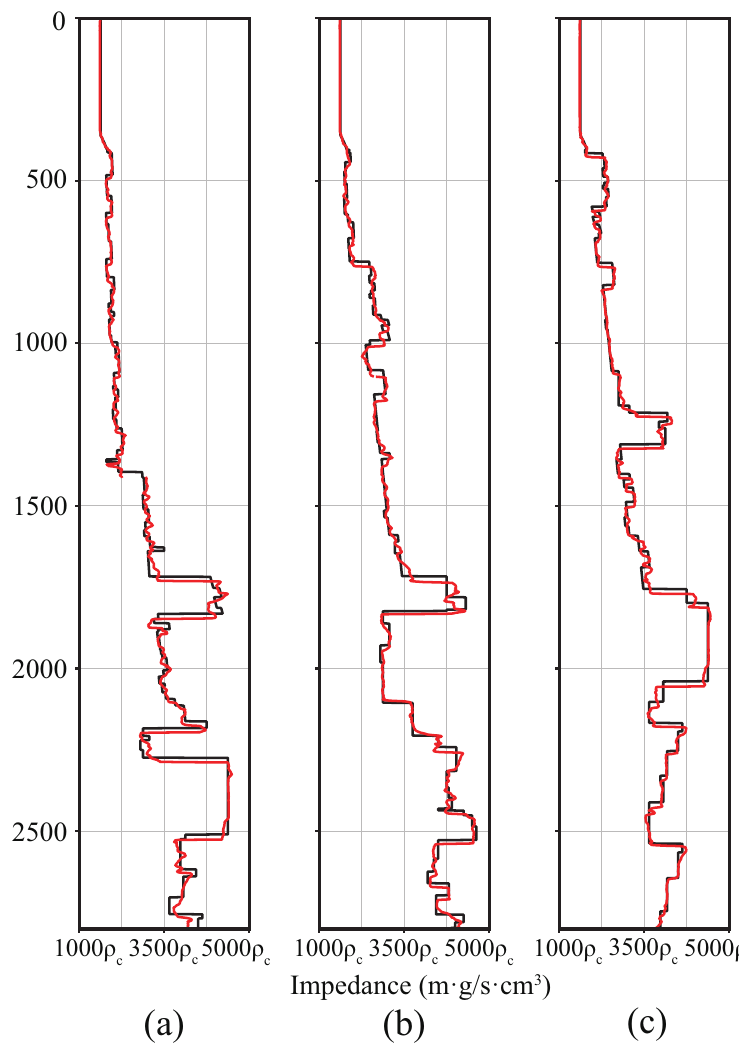
Figure 15. The predicted (red) and true (black) impedance of a single trace ( a ) No. 3500, ( b ) 8680, and ( c ) 12,200, from Marmousi